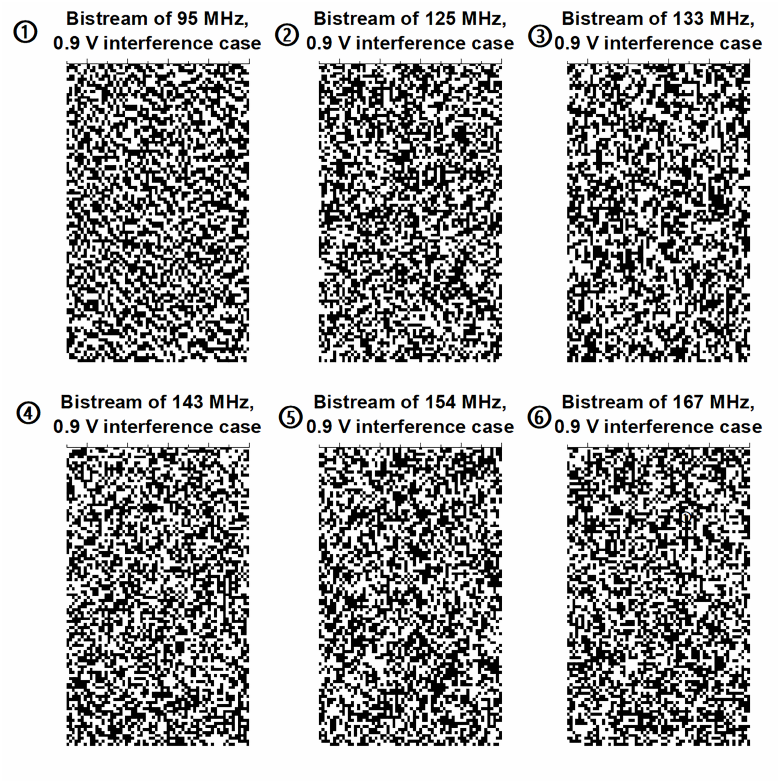
Figure 19. Bitstream of the improved TRNG under the selected interference